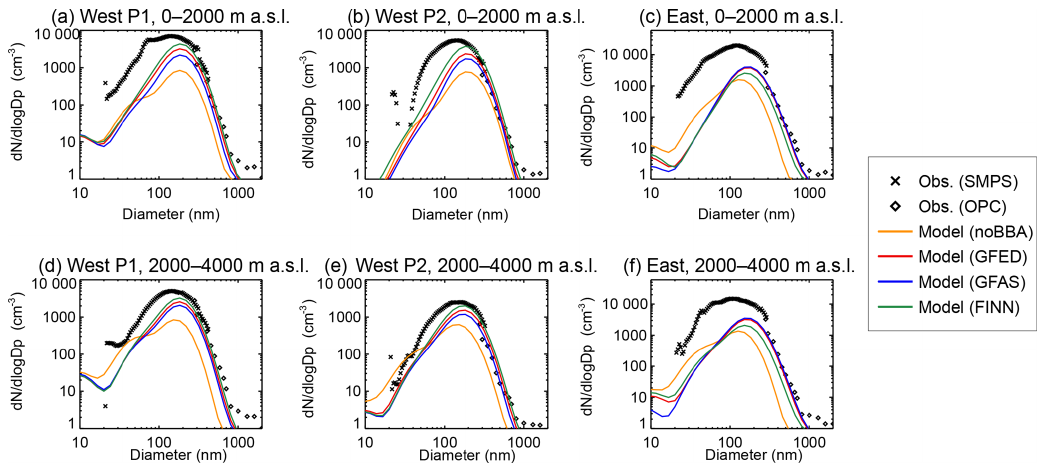
Figure 6. Mean observed (black) and simulated (colour) aerosol number size distributions during the SAMBBA aircraft campaign for two altitude bands: between the surface and 2km (a, b, c) and between 2 and 4kma.s.l. (c, d, e) . The observed number size distribution was measured with a scanning mobility particle sizer (SMPS; black crosses) and a Grimm optical particle counter (OPC; black diamonds). The simulated data (linearly interpolated to the flight track of the aircraft) and the observations are split into western and eastern regions of the Amazon (Fig. 2), as well as by time (P1: 13–22 September 2012, P2: 23 September–3 October 2012) for the western region. Simulated concentrations are shown for the model with FINN1.5 (green), GFAS1.2 (blue), GFED4 (red) emissions and with no biomass burning emissions (noBBA;